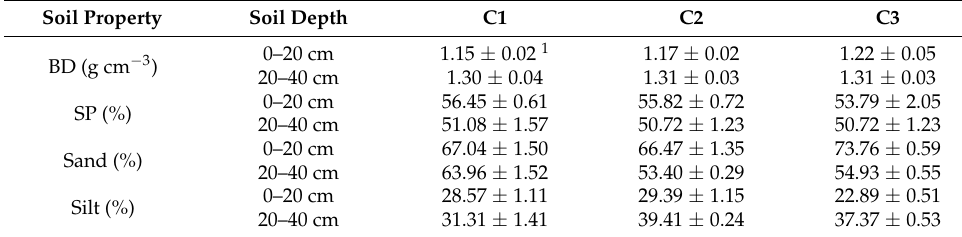
Table 1. Soil physical-chemical